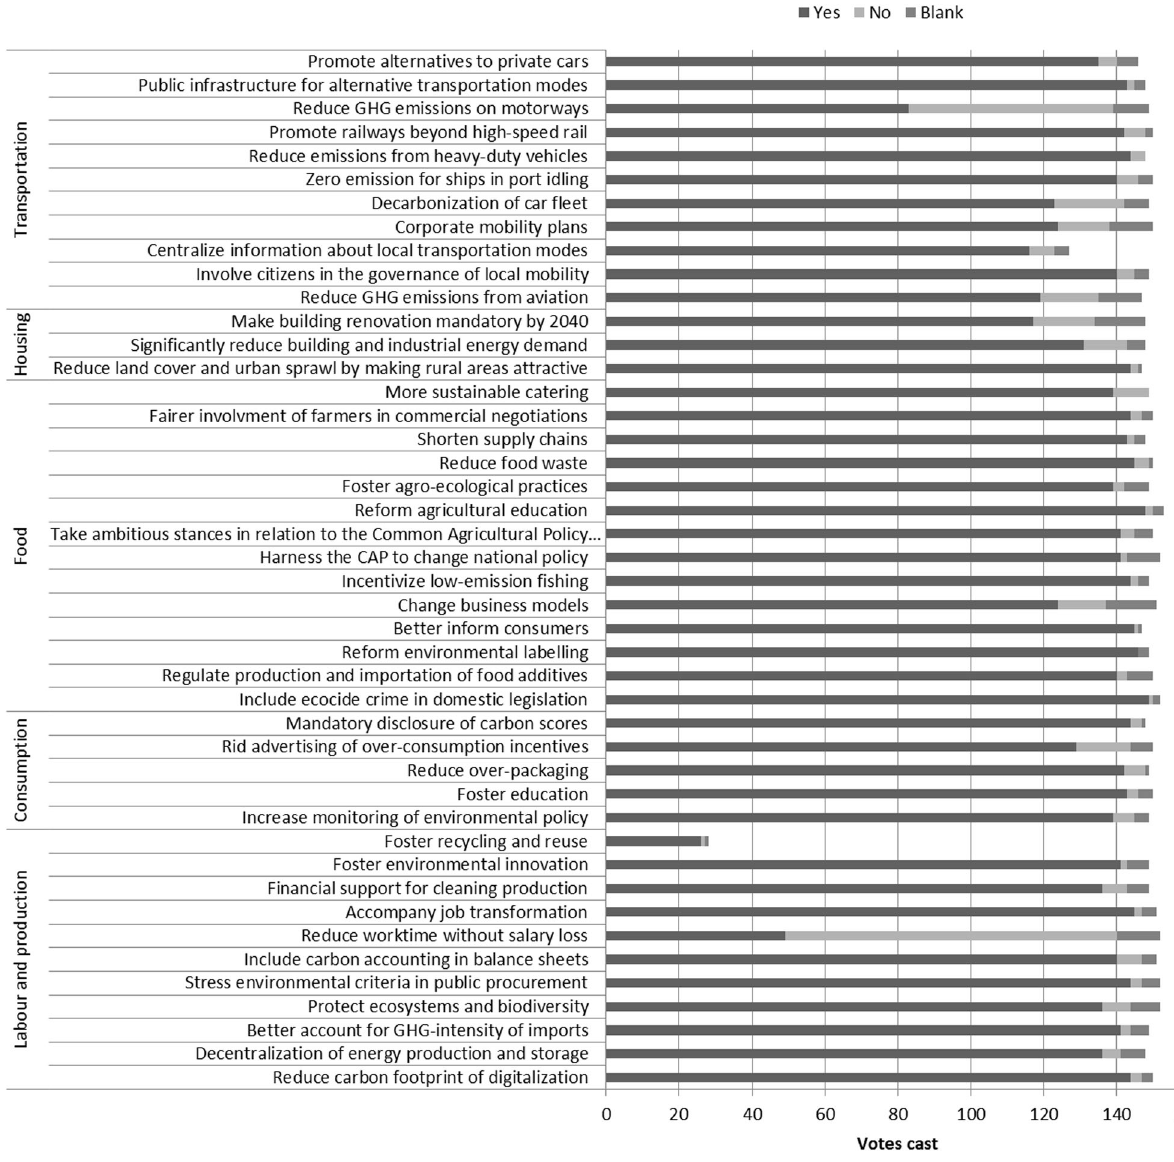
Fig. 1 Support for the 44 blocks of measures. The histograms indicate the votes cast for each block of